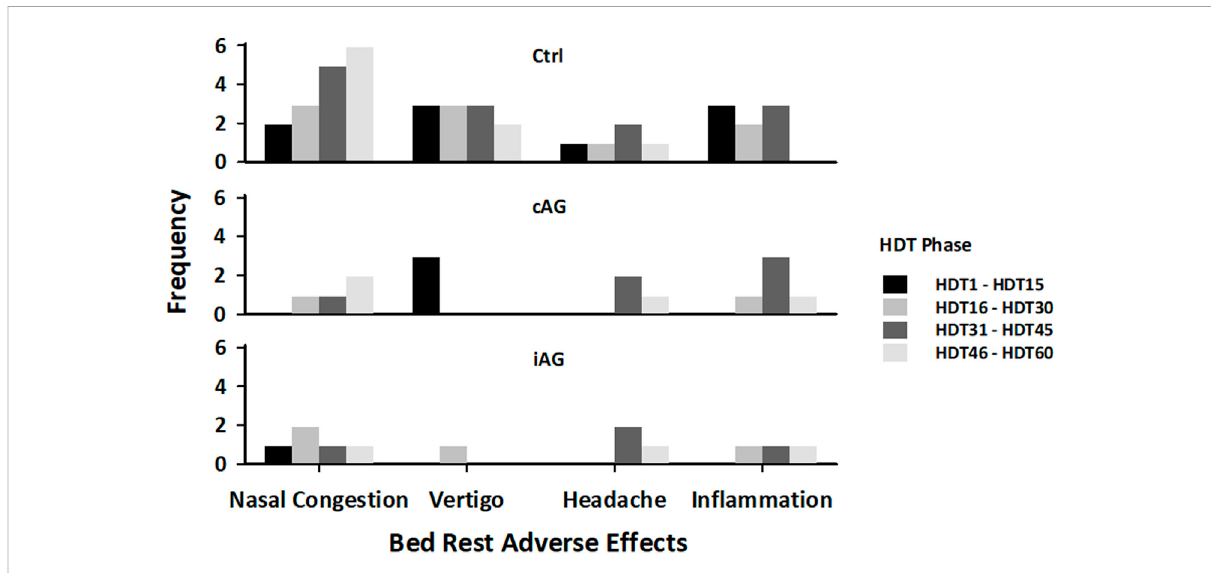
FIGURE 6 Frequency of adverse effects during the HDT phase for each subject